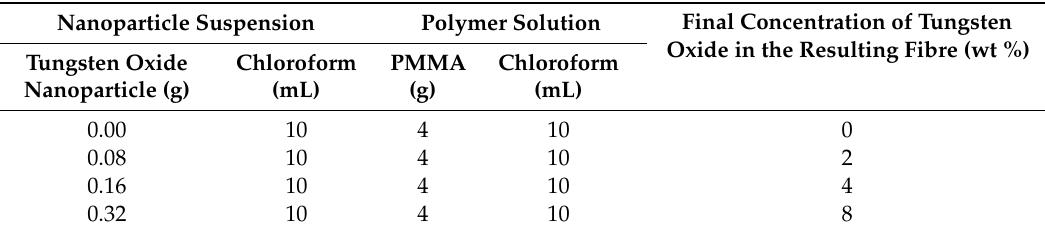
Table 1. Tungsten oxide / polymer solution